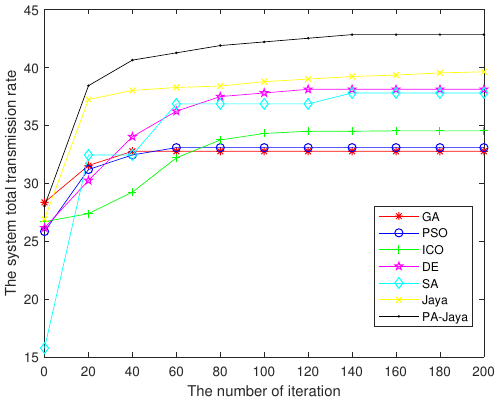
Figure 4. Relationship between the number of iterations and the total system transmission